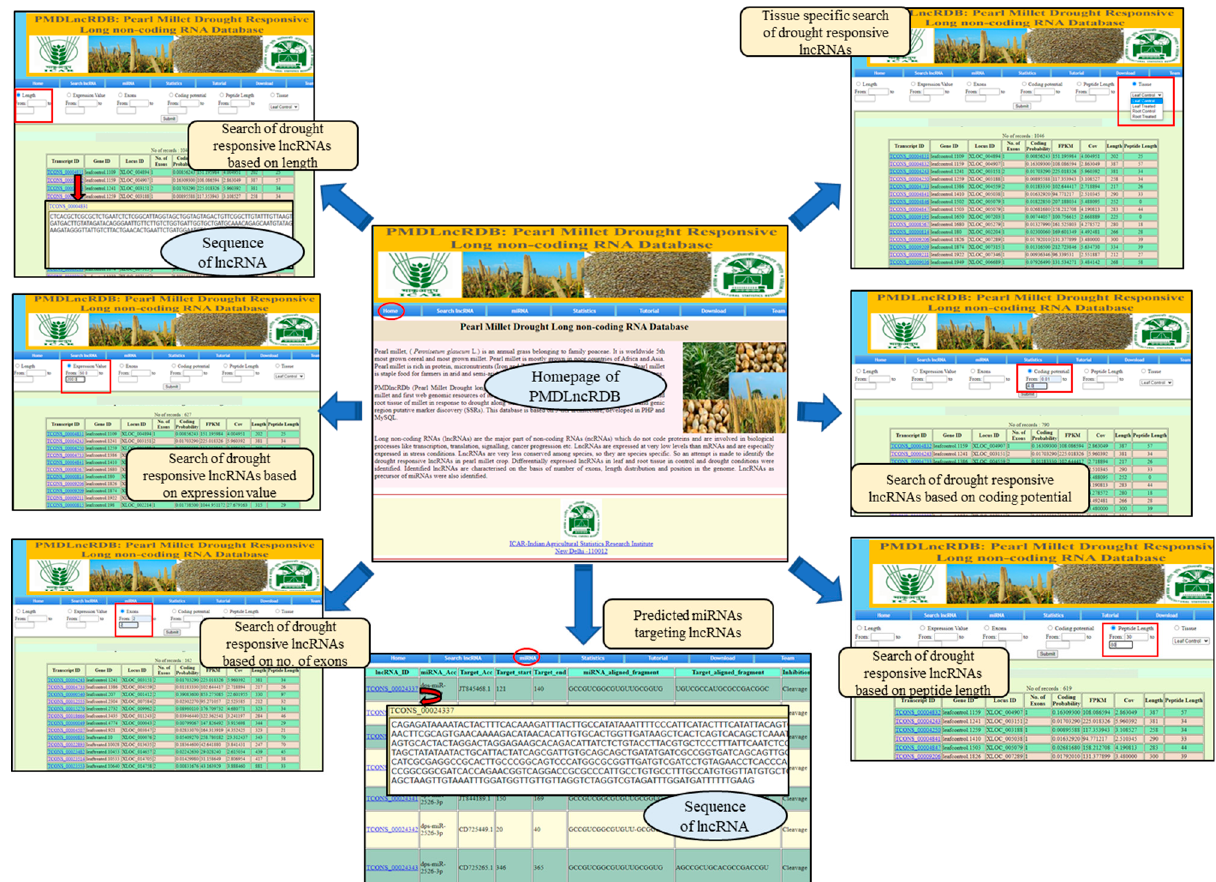
Figure 6. Web genomic resource PMDlnRDB.